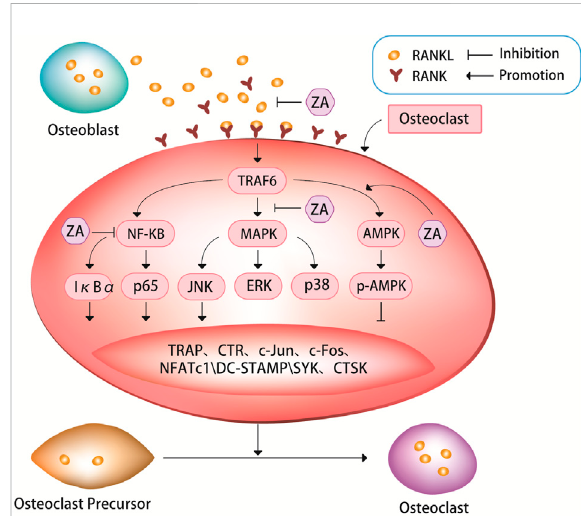
FIGURE 1 ZA can inhibit the RANKL/RANK signaling pathway. The bind of RANKL and RANK can activate a series of signaling pathways, such as nuclear factor kappa B (NF- κ B) pathway, mitogen-activated proteinkinases(MAPK)pathway,andAMP-activatedproteinkinase (AMPK) pathway. These signaling pathways can in turn cause tartrate-resistant acid phosphatase (TRAP), c-Jun, c-Fos, nuclear factor of activation of T cells-1 (NFATc1), c-Jun N-terminal kinase (JNK), dendritic cell Expression of speci fi c transmembrane protein (DC-STAMP), spleen tyrosine kinase (SYK), cathepsin K (CTSK) and other signaling molecules. It is through the RANKL/RANK signaling pathway that ZA regulates the expressionofthese signaling pathwaysandsignalingmoleculestoinhibitosteoclastdifferentiation and bone